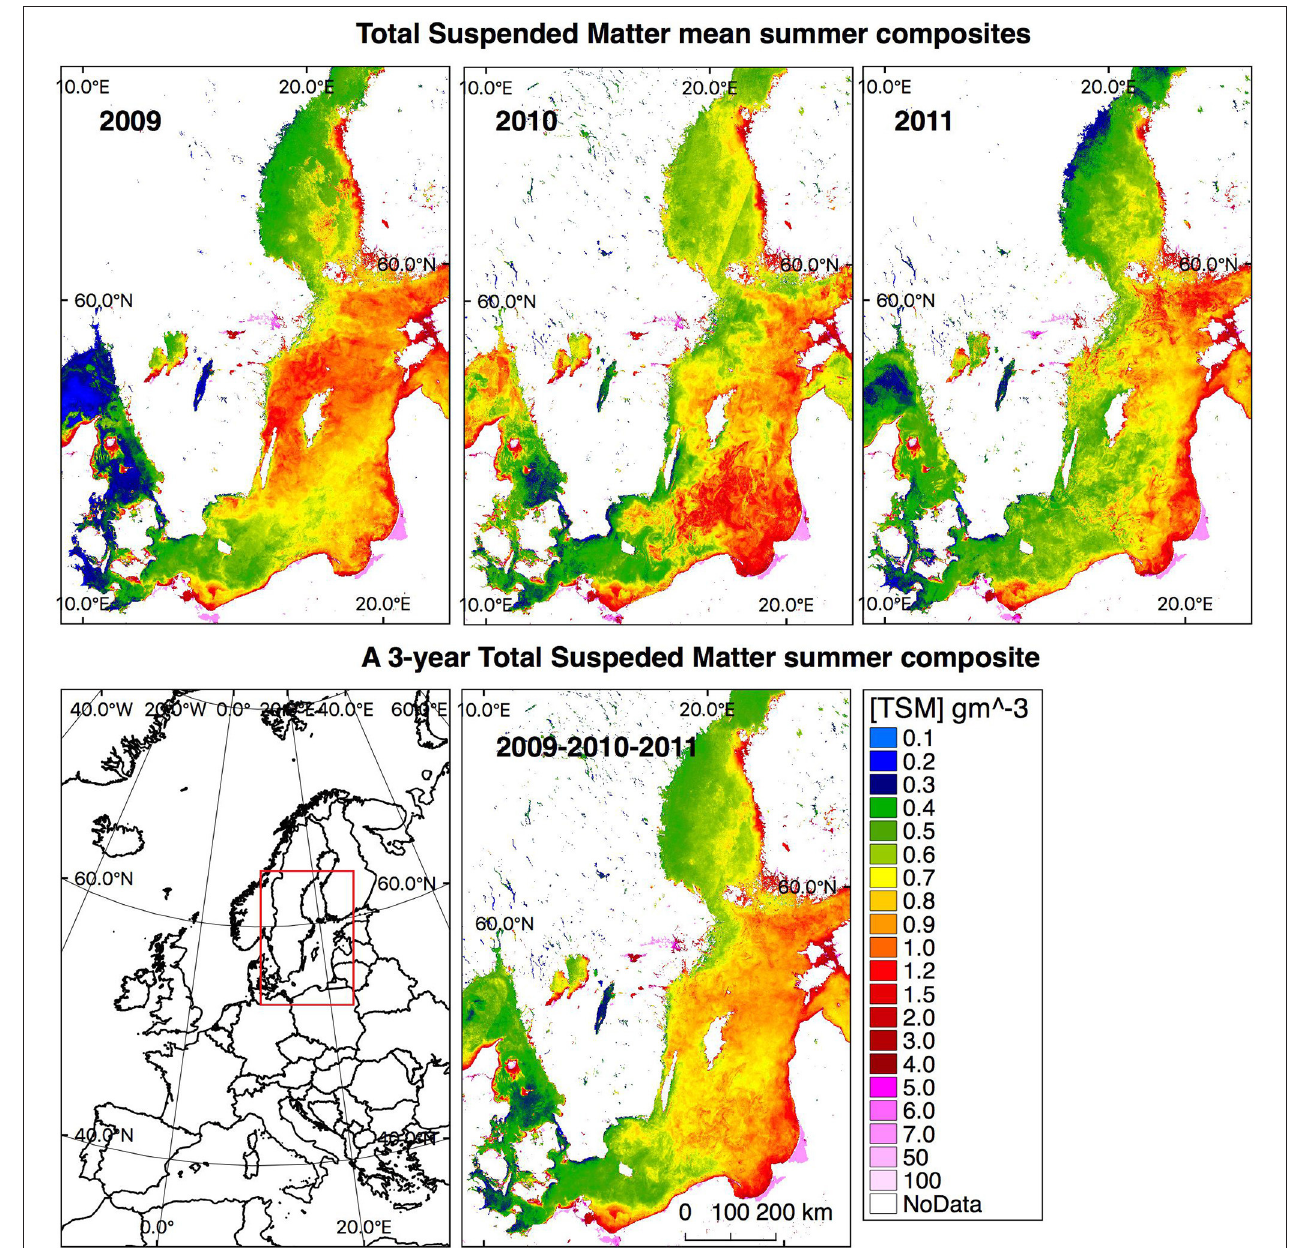
FIGURE 2 | Total Suspended Matter mean summer concentrations ( gm − 3 ) in 2009, 2010, 2011, and a 3-year summer composite in the Baltic Sea. Countries